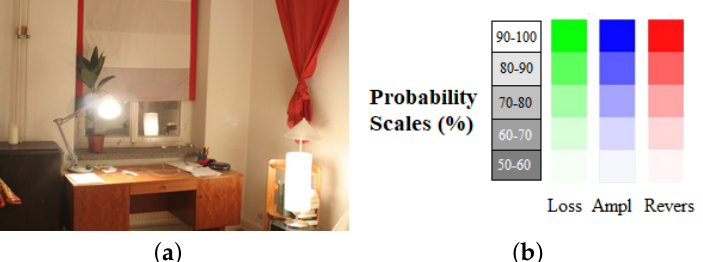
Figure 12. ( a ) The reference image for the prediction of the dynamic range independent metric. ( b ) The probability scale (%) with green for loss of visible contrast, blue for amplification of invisible contrast, and red for reversal of visible contrast for Image Quality Assessment